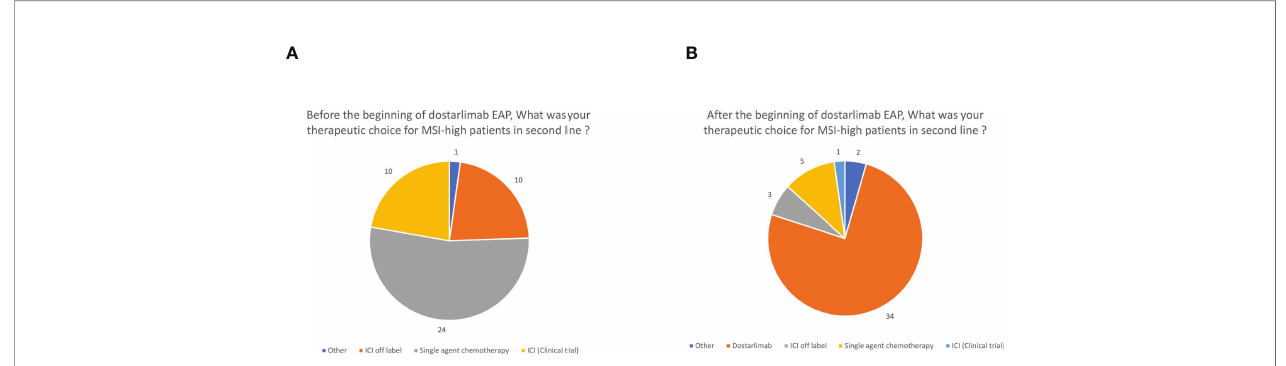
FIGURE 3 | Therapeutic choices before (A) and after (B) the beginning of dostarlimab expanded access program (EAP). ICI, immune checkpoint inhibitor other than dostarlimab.